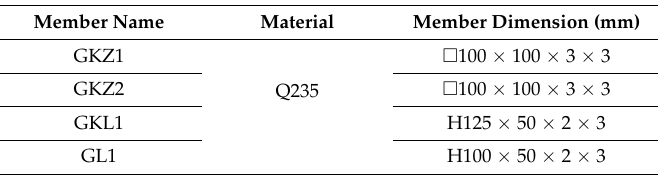
Table 1. Specific parameters of members.